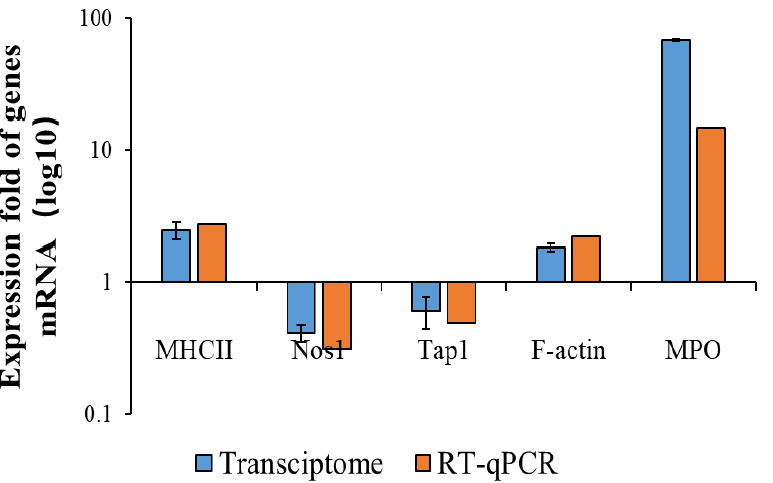
Figure 6. Comparison between transcriptome and RT-qPCR of some DEGs in the phagosome path-